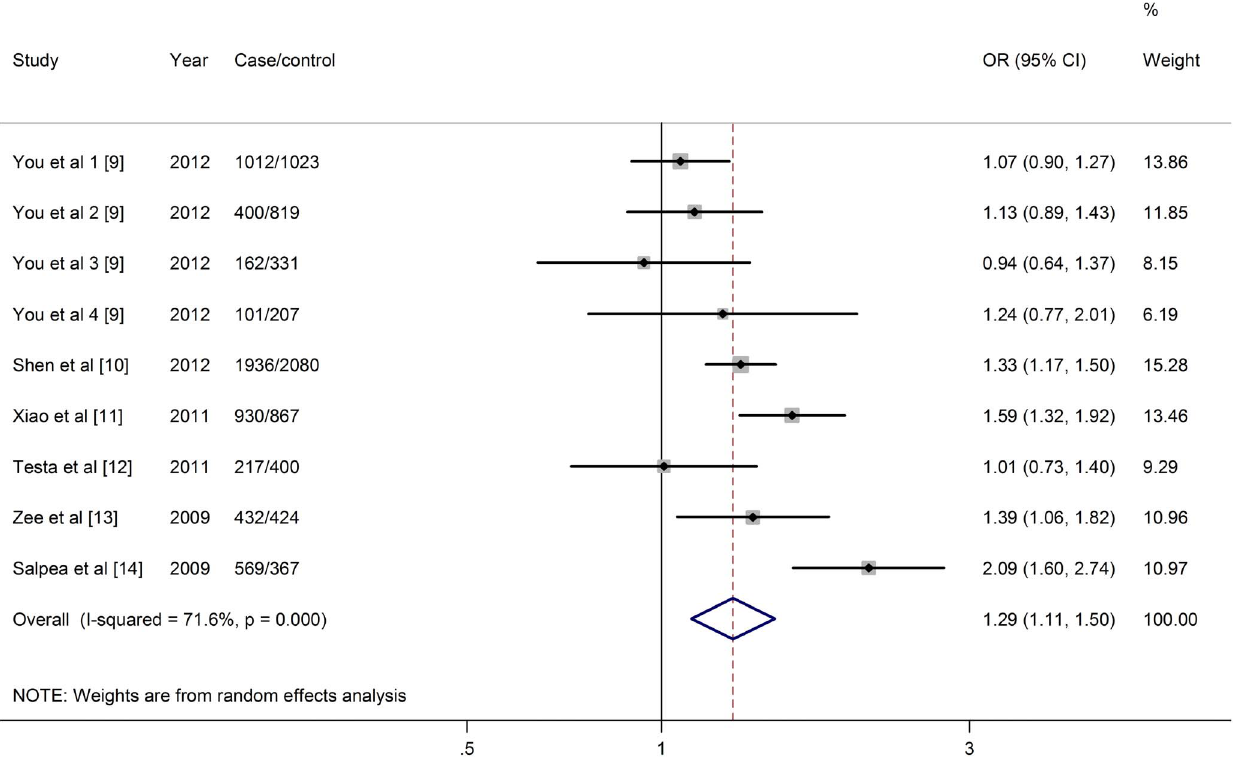
Figure 2. Meta-analysis of the association between telomere length and T2DM. Odds ratios (ORs) and 95% confidence intervals (CIs) for overall T2DM risk associated with relative telomere length (shorter vs. longer). doi:10.1371/journal.pone.0079993.g002 PLOS ONE |